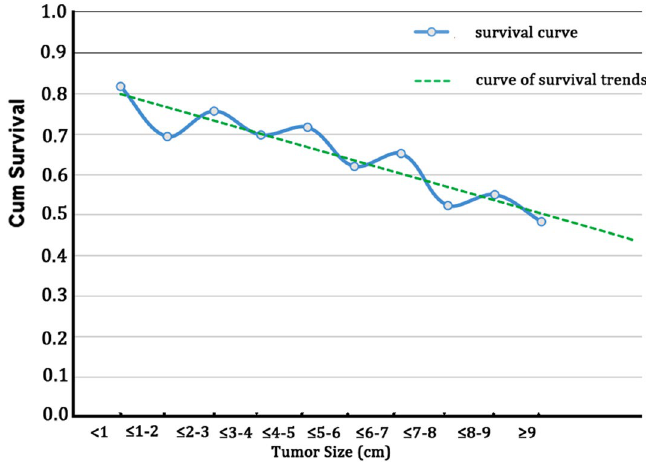
Figure 3. Distribution of cumulative survival by 1 cm tumor size intervals.